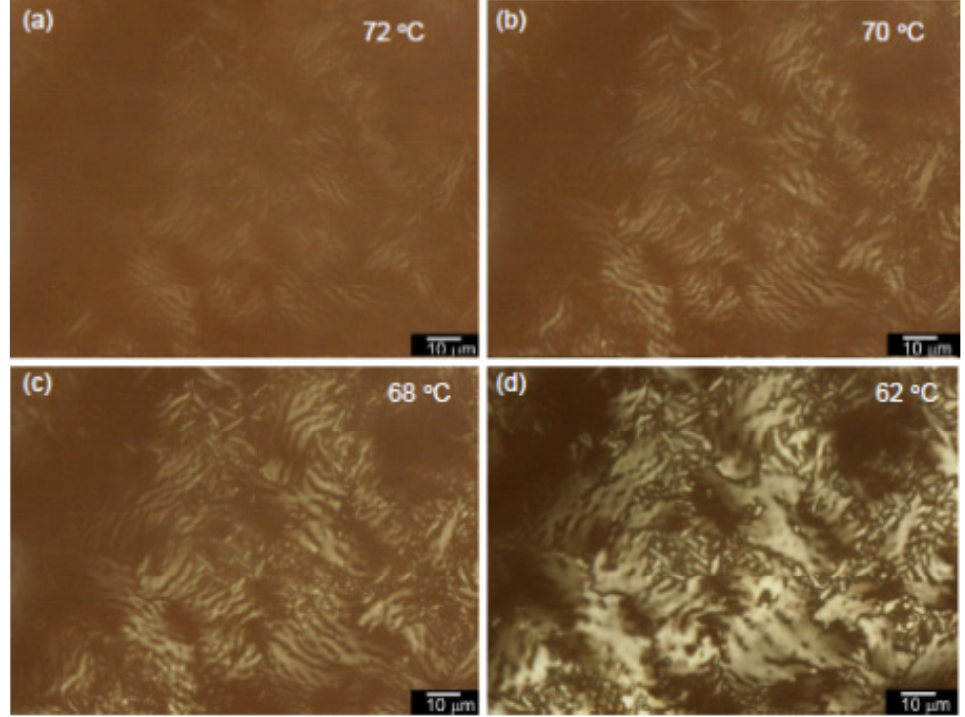
Figure 6. Polarizing optical microscopy (POM) images of polyITN-Pyr from 72 °C to 62 °C in the cooling